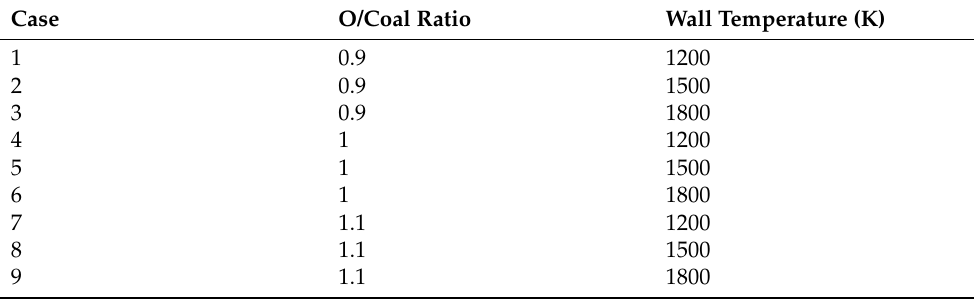
Figure 3. Temperature (K) distribution w.r.t height (m) for the grid sensitivity analysis (four grid sizes). Table 4. Simulation case for various oxygen/coal ratios and wall temperatures.